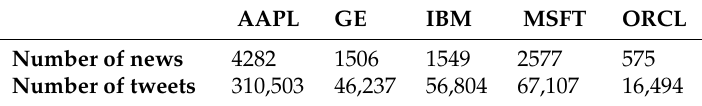
Table 1. Total data for 137 days (20 April 2015 to 30 October